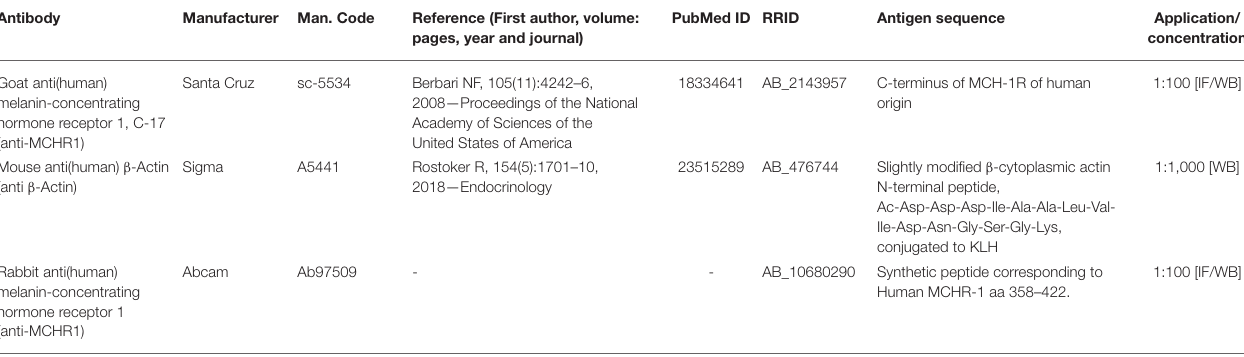
TABLE 2 | Primary antibodies used in the experiments. Antibody Manufacturer Man.